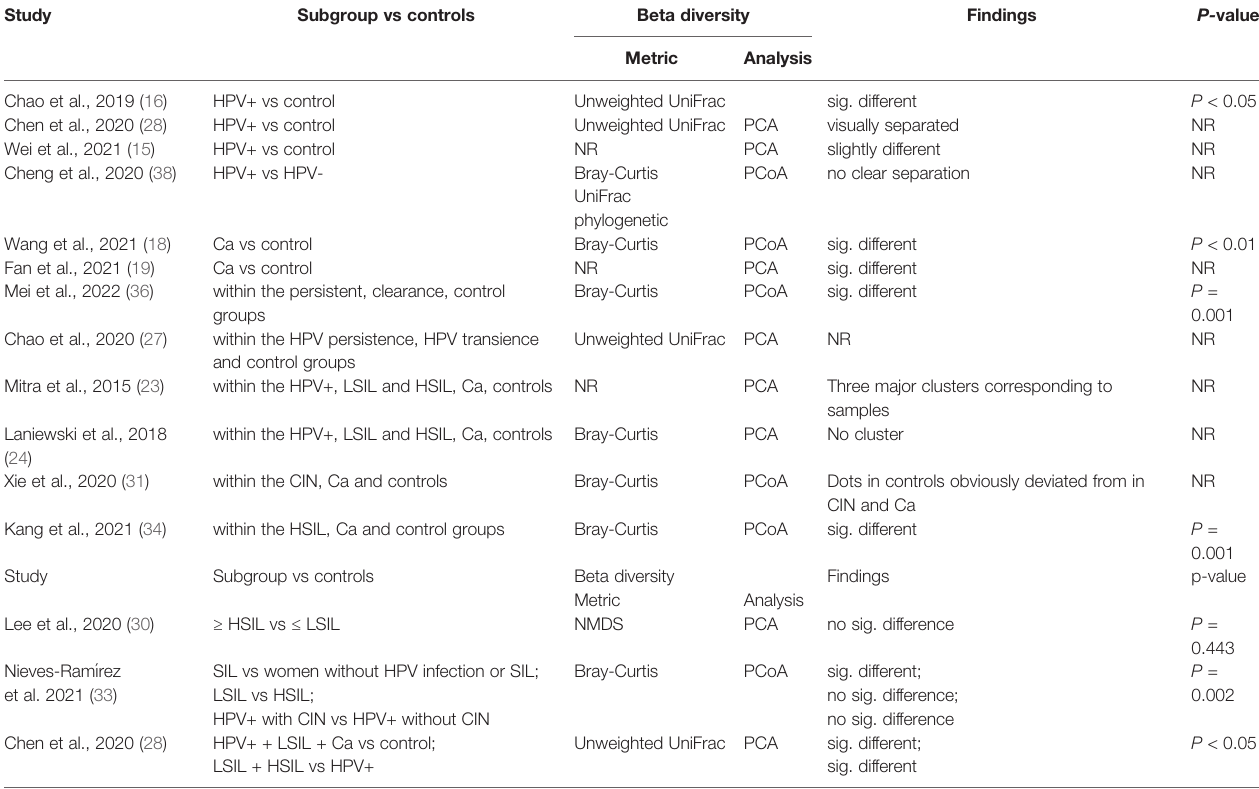
TABLE 3 | Beta diversity reported by